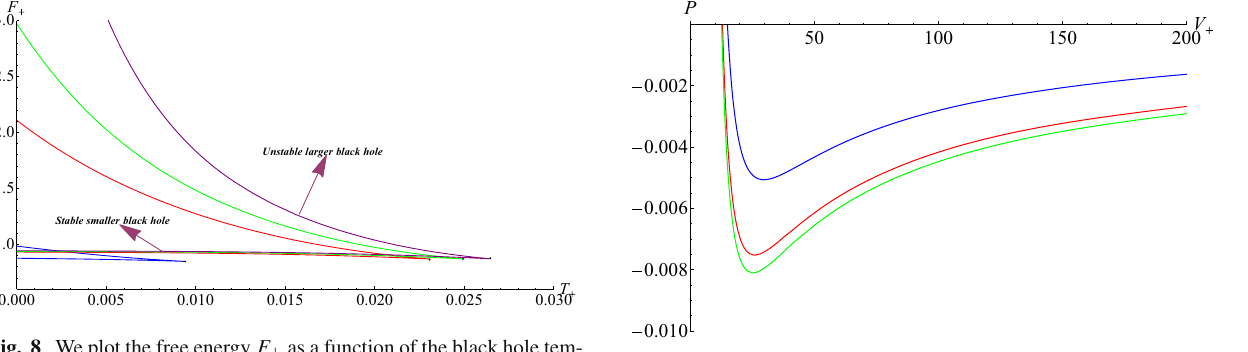
Fig. 9 We plot the thermodynamic pressure in terms of the thermody- namic volume V + , under the different values of the temperature, at the magnetic charge Q = 1. The blue, red, and green curves correspond to T = 0 . 05, 0 . 01, 0 .